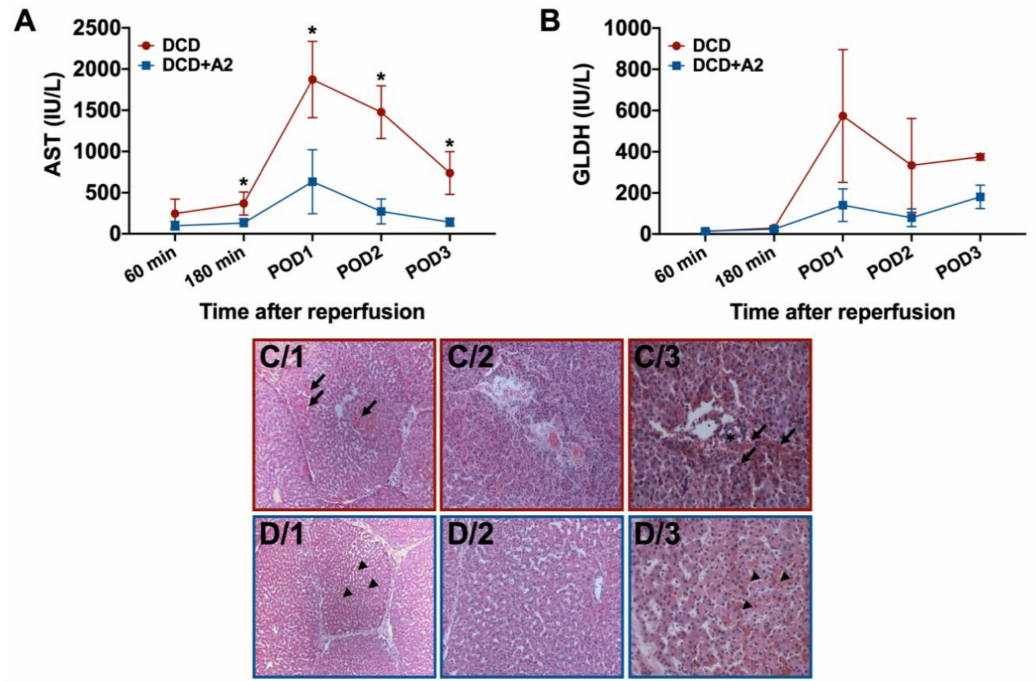
Figure 3. Hepatocellular damage and histopathology. ( A ) Time course of serum aspartate-aminotransferase (AST) levels expressed in IU / L in the DCD and DCD + A2 groups (mean ± s.e.m., * p < 0.05 DCD + A2 vs. DCD, Student’s t -test, n = 5 / group) ( B ) Time course of serum glutamate dehydrogenase (GLDH) levels expressed in IU / L in the DCD and DCD + A2 groups (mean ± s.e.m., n = 5 / group ( C1 – 3 ) Representative microscopic images of the histological specimens at sacrifice in the DCD group (stained with hematoxylin-eosin; original magnification 100 × , 200 × , 400 × , respectively). ( D1 – 3 ) Representative microscopic images of the histological specimens at sacrifice in the DCD + A2 group (stained with hematoxylin-eosin; original magnification 100 × , 200 × , 400 × ,